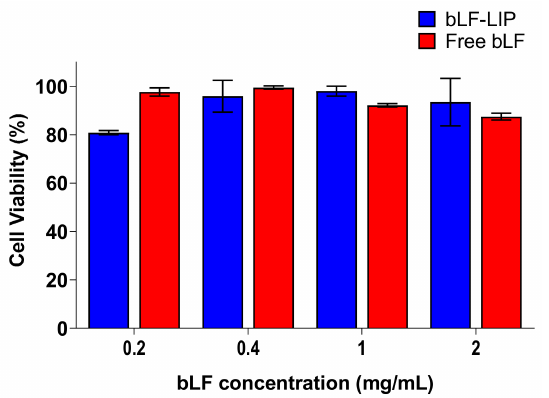
Figure 5. Effect of bLF-LIP on the viability of HCE-2 cells. The 100% cell viability corresponds with the average of MTT reduction values of untreated